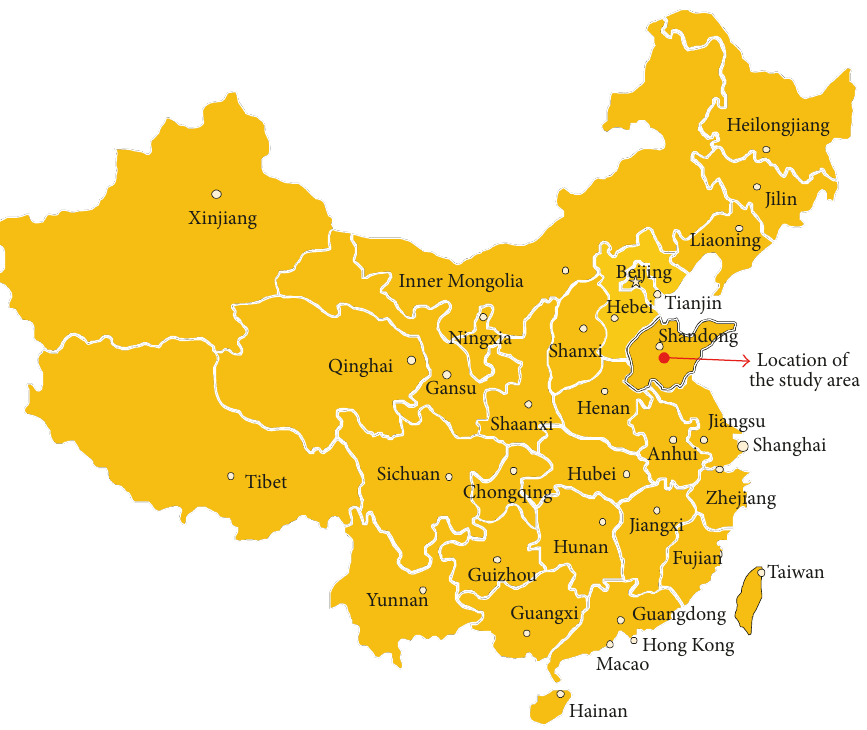
Figure 3: Location of the case study